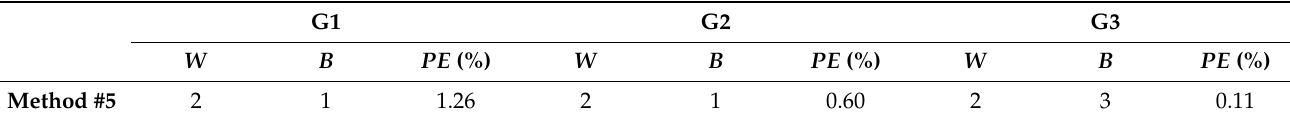
Table 3. Optimal values for W and A for Method #5 and resulting PE . G1 G2